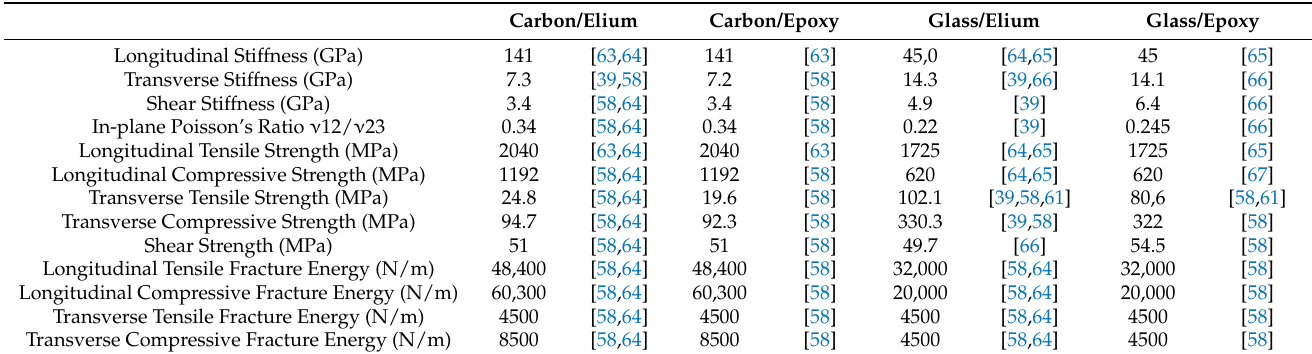
Table 2. NCF ply properties used in the analyses.